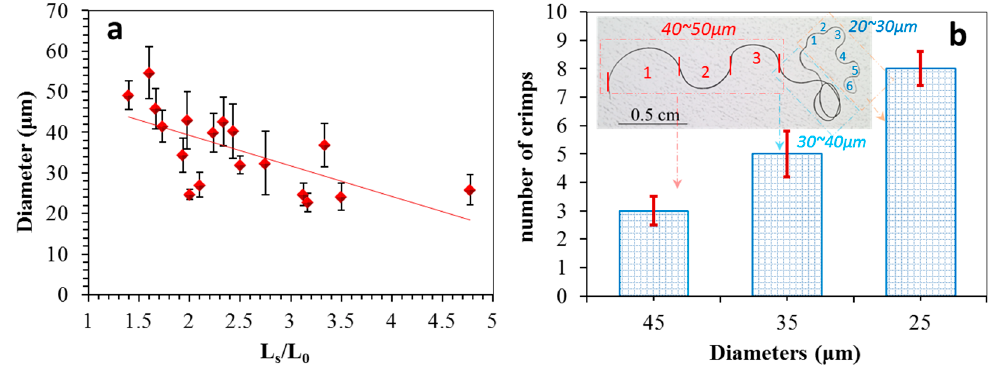
Figure 3. Physical properties of yak hairs. ( a ) Measured relationship of hair diameter and ratio of stretched hair length (L s ) to natural crimped hair length (L o ). ( b ) Distribution of crimp numbers along a mature yak hair from its coarse to fine parts.